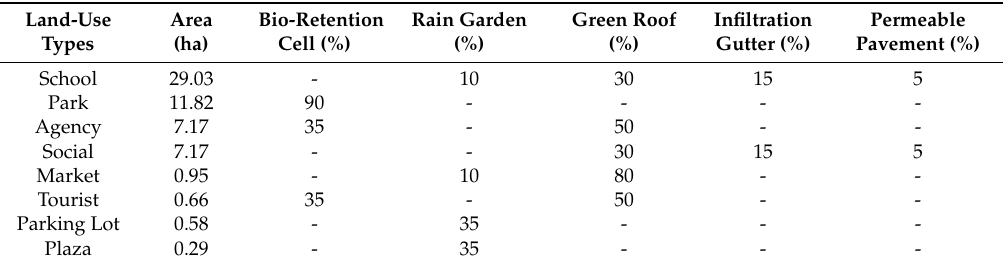
Table 10. Area ratios of different LID facilities with respect to land-uses.